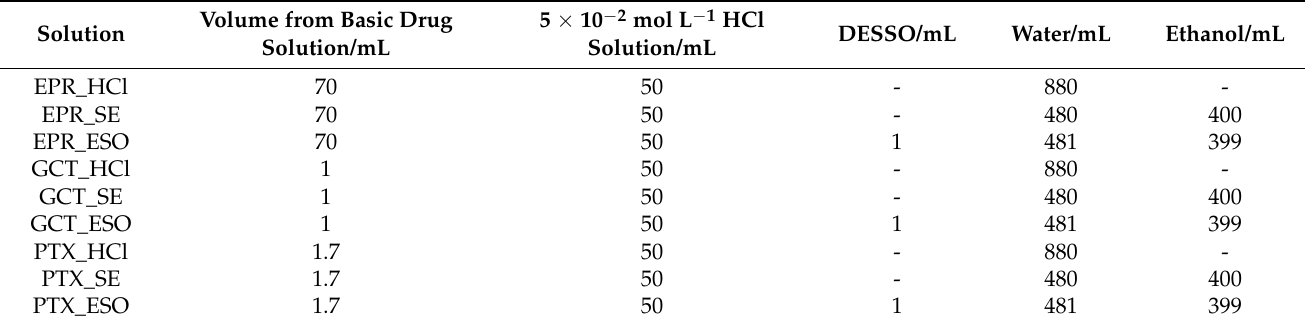
Table 7. The composition of studied